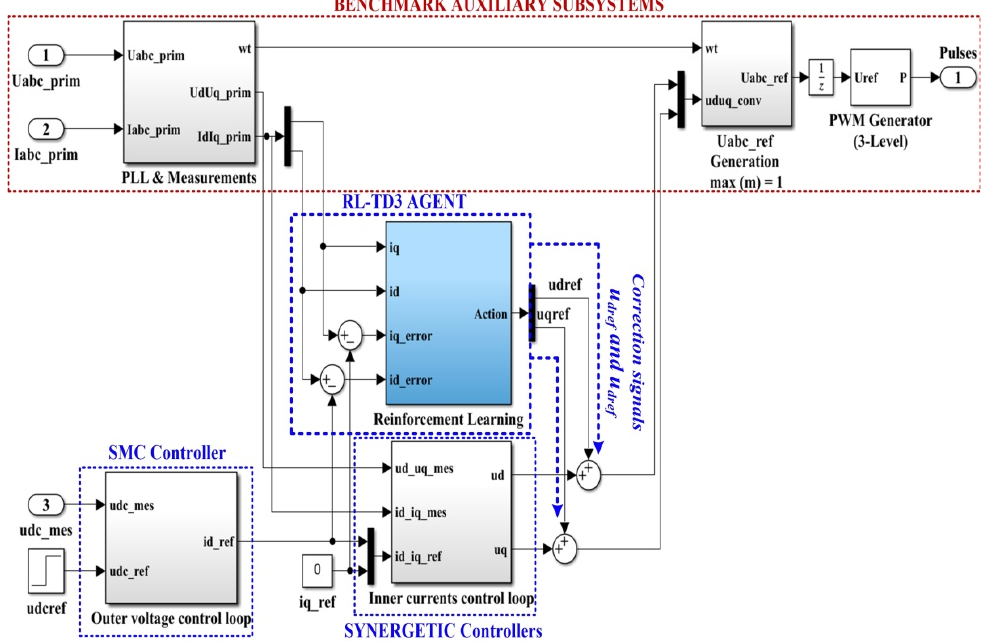
Figure 23. The MATLAB Simulink subsystem block implementation of the control system for the GC-PV array based on SMC and SYN and using the RL-TD3 agent for the correction of the u dref and u qref command signals.